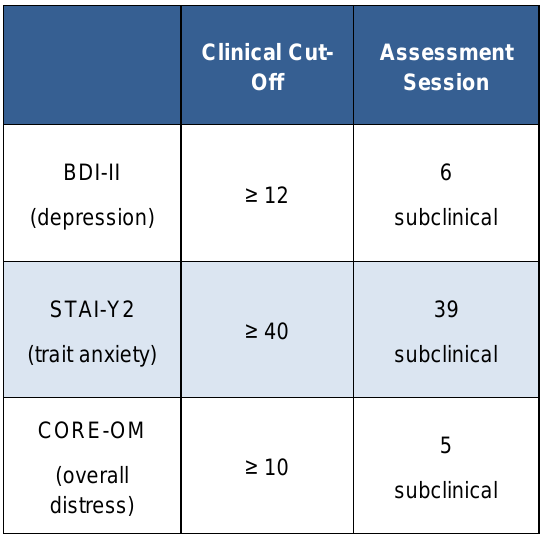
Table 1: Quantitative assessment outcome